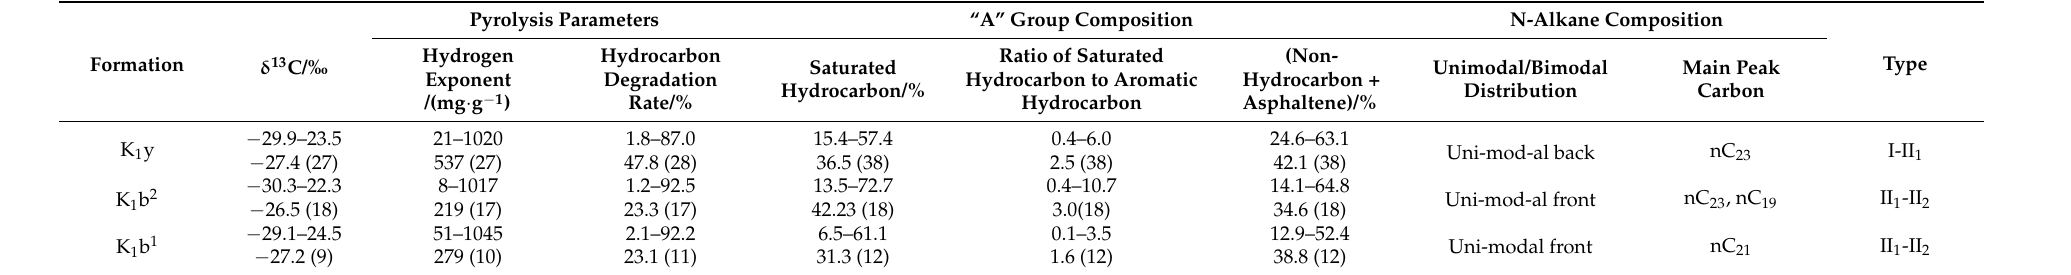
Table 2. Parameters of kerogen types for main source rocks in the Hari sag.